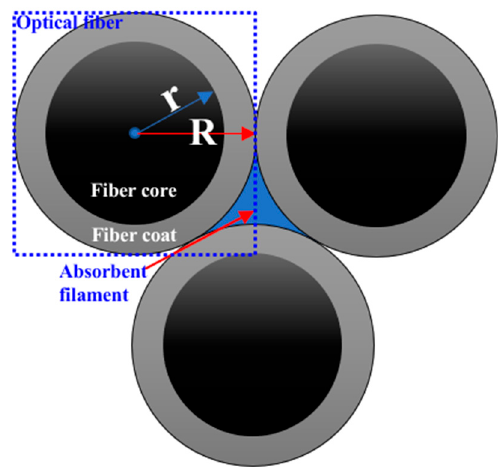
Sensors 2020 , 20 , x FOR PEER REVIEW